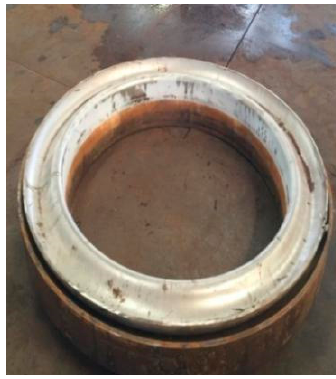
Figure 14. Sliced bellow.